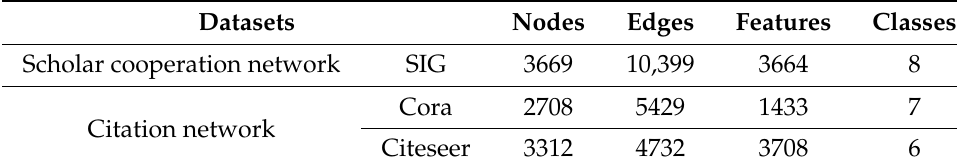
Table 2. Summary of the